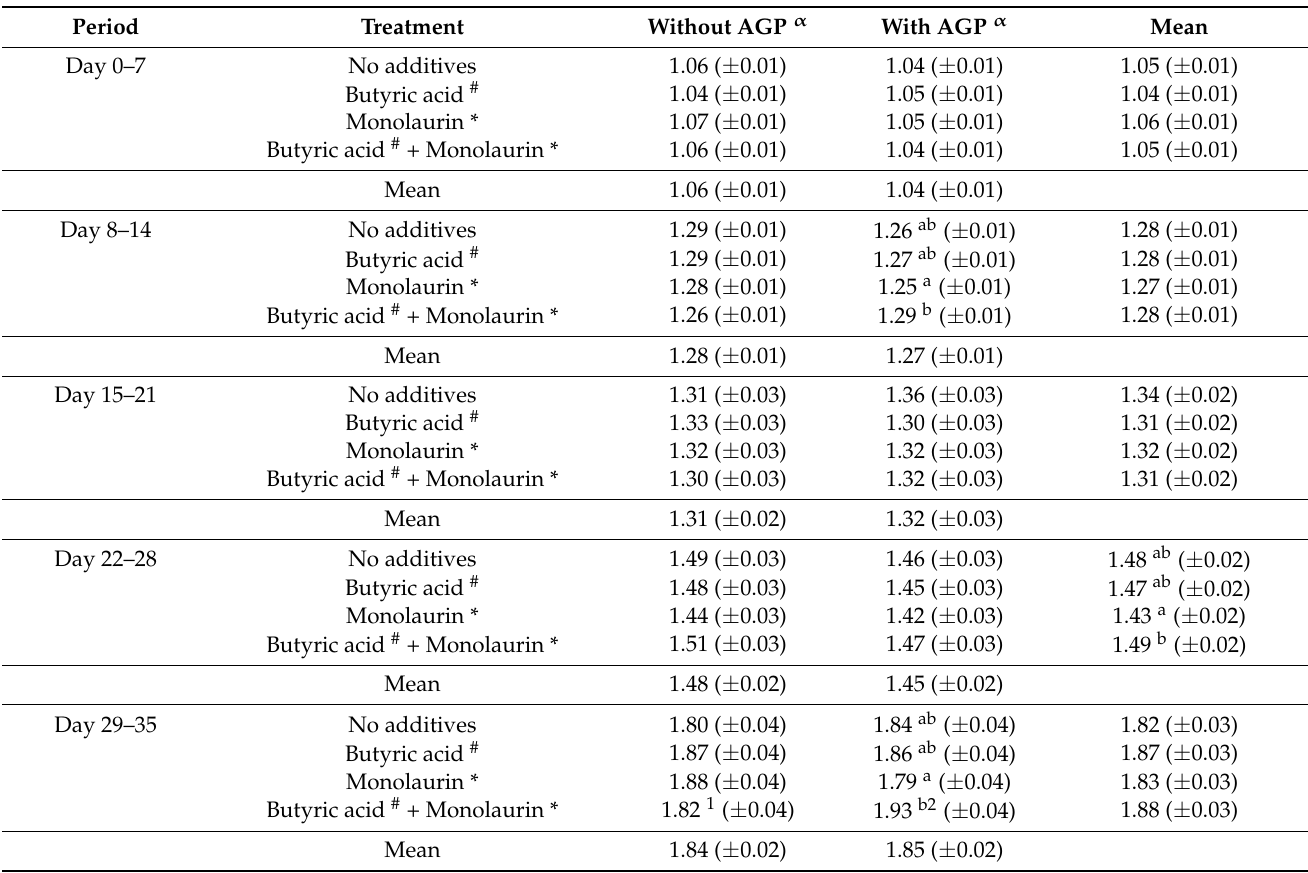
Table 3. The effect of butyric acid and α -monolaurin, with and without the inclusion of an antibiotic growth promoter (AGP), on weekly and overall feed conversion ratio of broilers ( ± standard error of the mean).